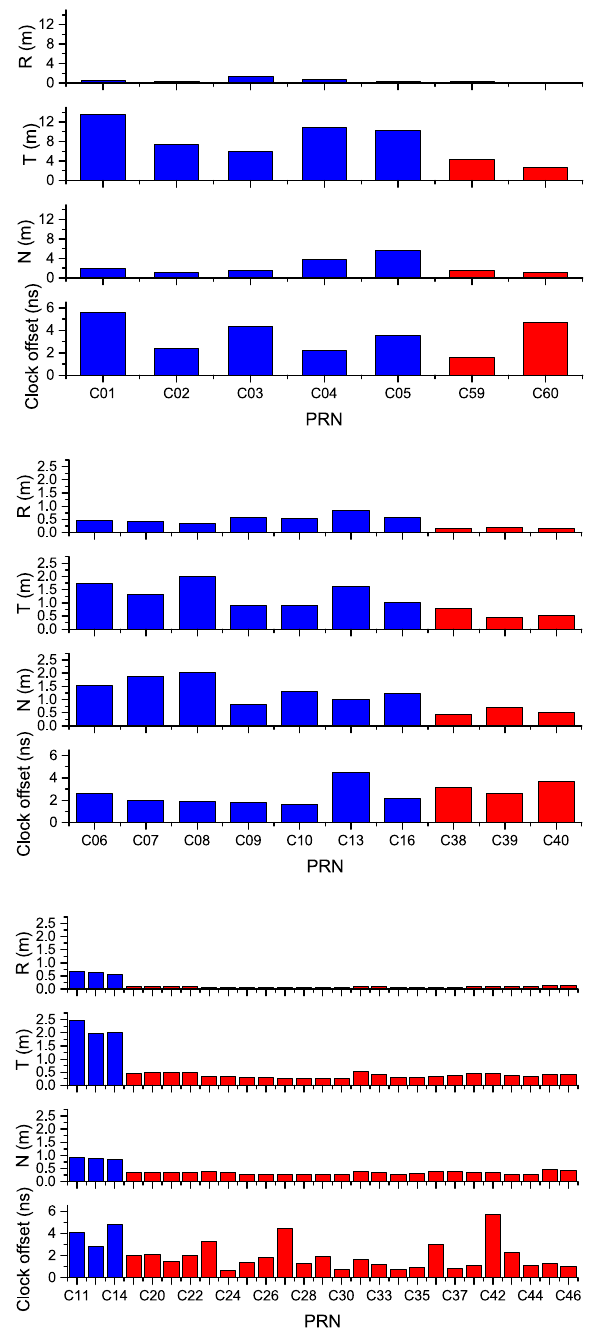
Figure 5. Comparison of BeiDou orbit and clock offset accuracies for three categories of GEO (top), IGSO (middle), and MEO (bottom). The blue and red bars denote BDS-2 and BDS-3 satellites,